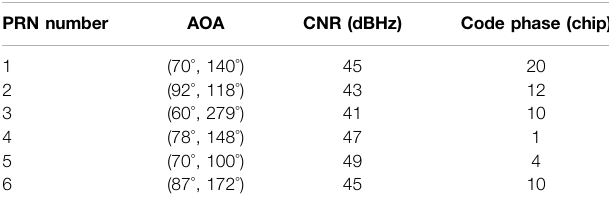
TABLE 5 | Real satellite signal parameter